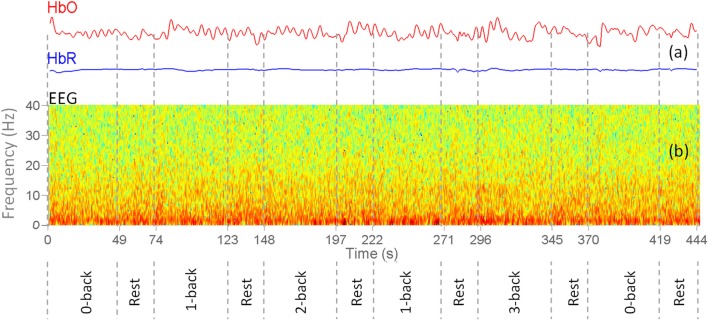
Sample preprocessed EEG+fNIRS data for one of the subjects. Vertical dashes separate different n-back task and rest blocks. (a) Concentration changes of oxy-hemoglobin (red curve) and deoxy-hemoglobin (blue) for channel 17. (b) EEG Time-frequency map of the channel O2.